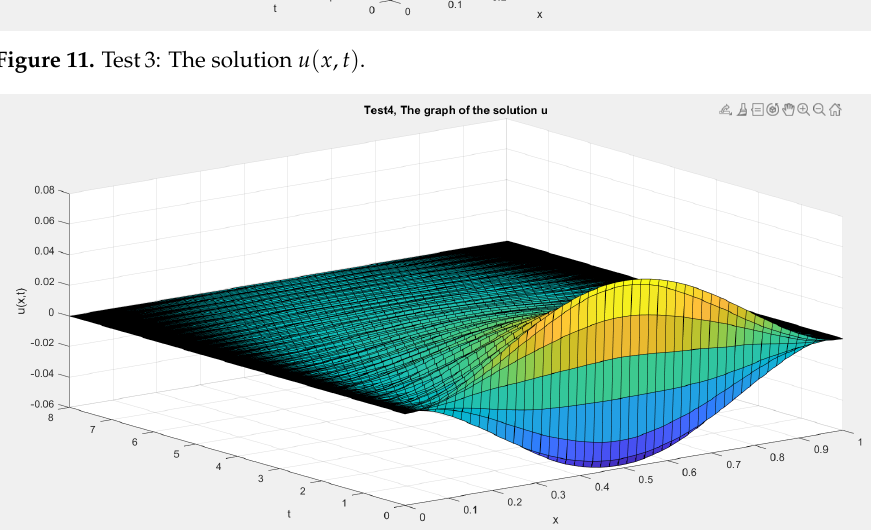
Figure 12. Test4: The solution u ( x , t )